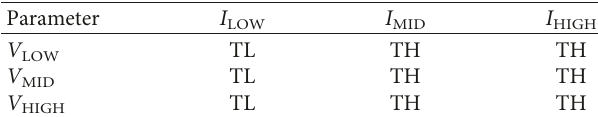
Figure 2: Flow chart of the proposed CDFTF-based scheme. Table 1: Fuzzy rule base for fuzzy-based faulty phase